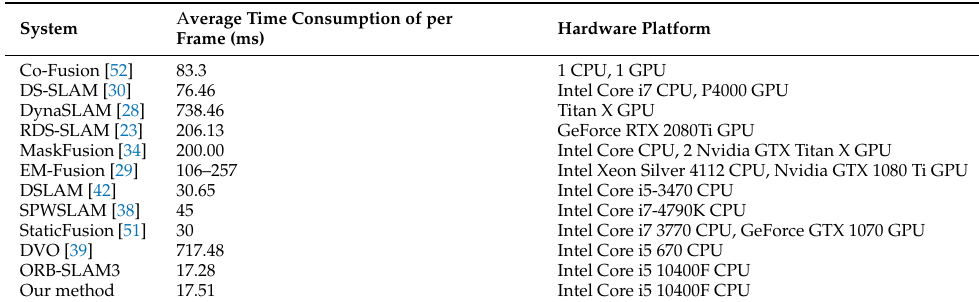
Table 5. Comparison of the real-time performance in dynamic environments.